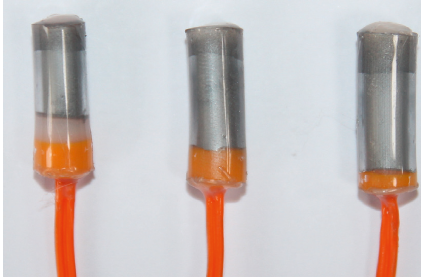
Figure 5: Photo of explosives.